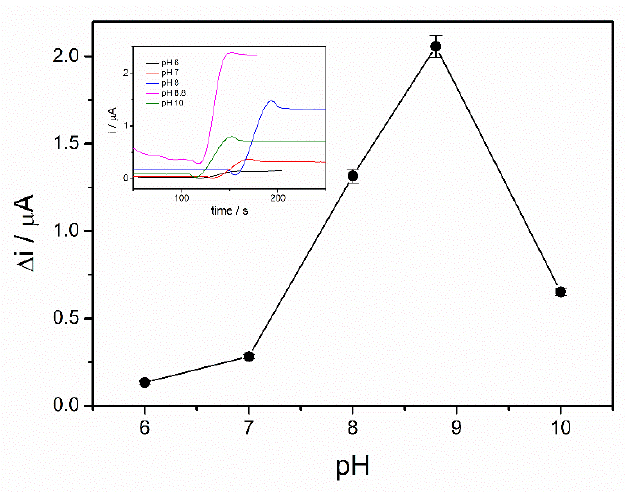
Figure 3. Influence of pH on the biosensor response (PBS 0.1 M, 10 mM NAD + , 4 mM ethanol, n = 3) (inset: chronoamperometric response curves at pH between 6 and 10).